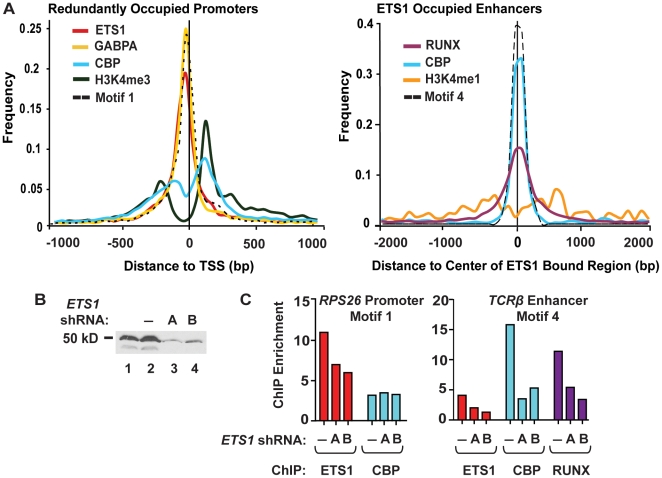
Distinct properties of promoters and enhancers occupied by ETS1.(A) Factor or histone modification positions were plotted as a class average across redundant promoters (left) or ETS1 occupied enhancers (right). At redundant promoters, the occupancy profiles of ETS1, GABPA, CBP, H3K4 tri-methyl, and Motif 1 were plotted from the center of each occupied region to the nearest RefSeq TSS. At ETS1-occupied enhancers, the occupancy profiles of RUNX1, CBP, H3K4 mono-methyl, and Motif 4 were plotted with respect to the center of the ETS1 bound region. For each factor, histone modification, or motif, a histogram of 30 bp bins was generated to represent the frequency of occupancy for each distance. The number of occurrences at each distance was normalized to the total number of regions with an occurrence of each factor, histone modification, or motif. A vertical line indicates the zero position of each chart (TSS or center of ETS1 bound region). (B) Protein immunoblot of Jurkat whole cell extracts with the ETS1 antibody. Lane 1, no shRNA; Lane 2, negative control shRNA targeting luciferase; Lanes 3 and 4, two independent shRNAs (A and B) targeting ETS1. The two bands apparent in Lanes 1 and 2 are consistent with the 51 and 42 kDa splicing isoforms of ETS1. (C) ETS1, CBP, and RUNX ChIP enrichment at the TCRβ enhancer and the RPS26 promoter. The shRNAs were expressed in Jurkat T cells prior to ChIP, as indicated. Two independent biological replicates provided similar patterns, but different maximum levels of enrichment. A representative experiment is shown. Primer sequences used are provided in Table S3.